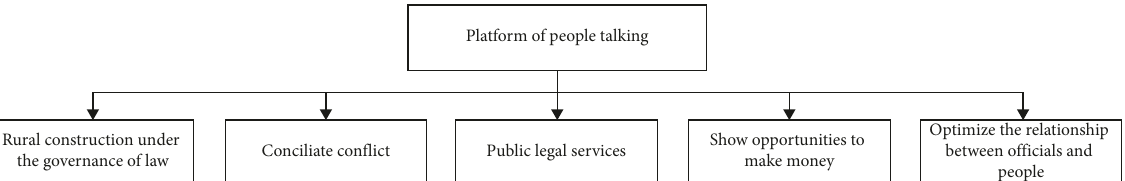
Figure 3: Platform of people talking in J City.